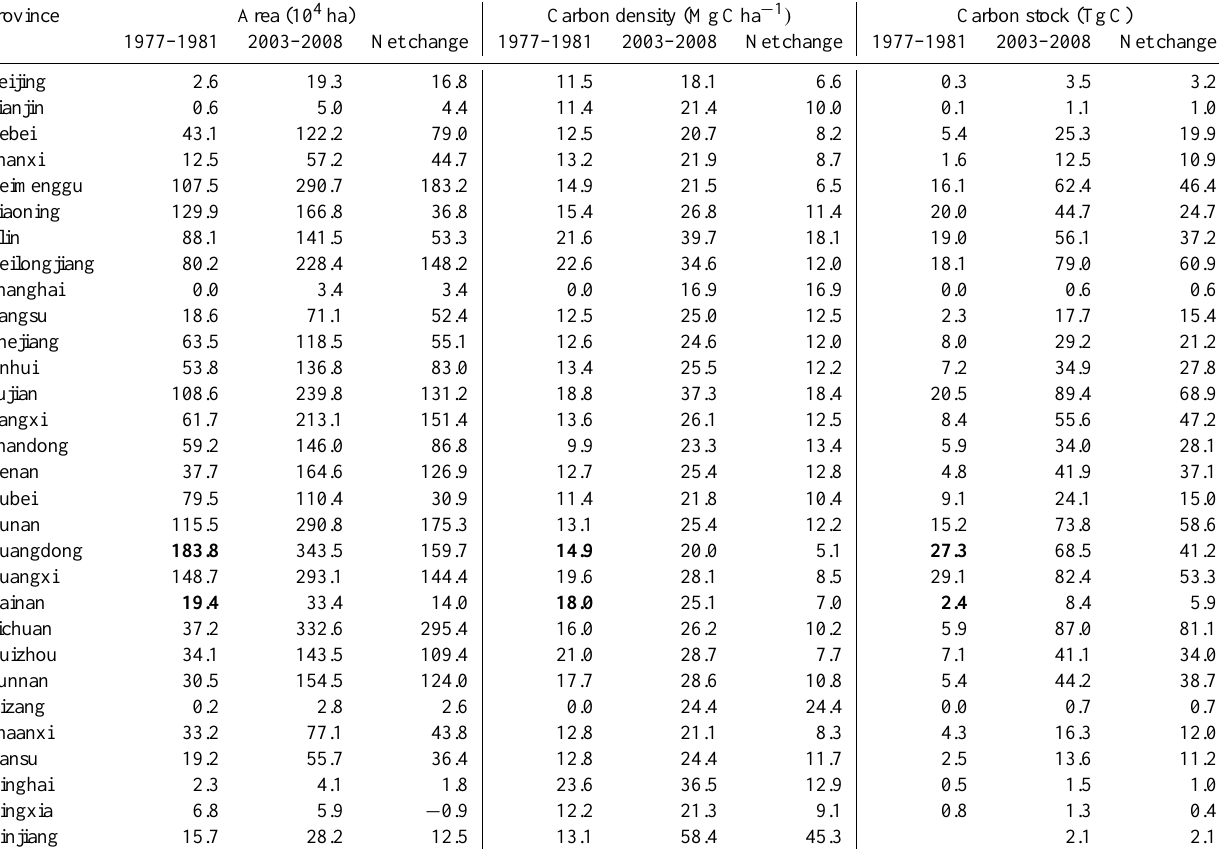
Table C1. Changes in forest area, carbon density, and carbon stock for planted forests in provinces of China for the period 1977–2008.